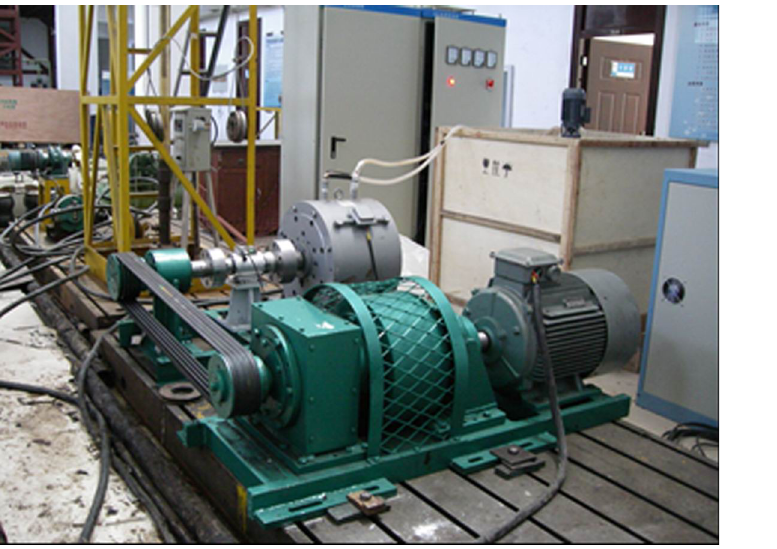
Fig 1. Experimental apparatus for external characteristics of the